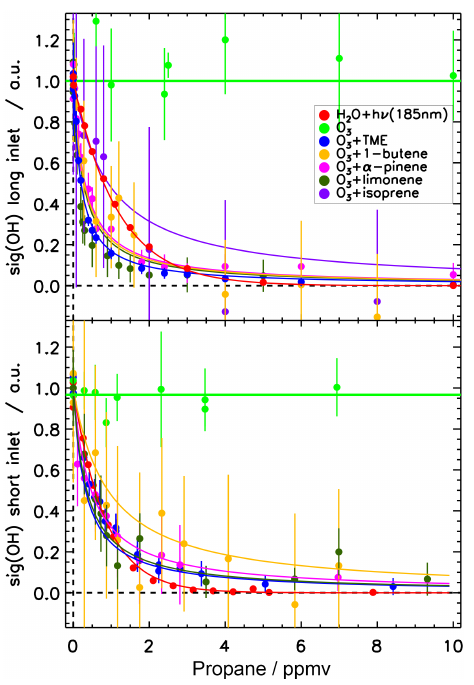
Figure 4. Relative OH signals during flow tube experiments de- pending on the propane mixing ratio. Each decay curve (distin- guished by different colours) corresponds to a different OH pro- duction mechanism. OH was produced by water photolysis (normal operation of the calibration source), by ozone inside the cell, or by ozonolysis of various alkenes in dry air. Lines are arbitrary fits to guide the eye in this plot. Results obtained with the cell with the long inlet (top) and short inlet (bottom) are shown here. Experi- mental conditions can be found in Table 1.